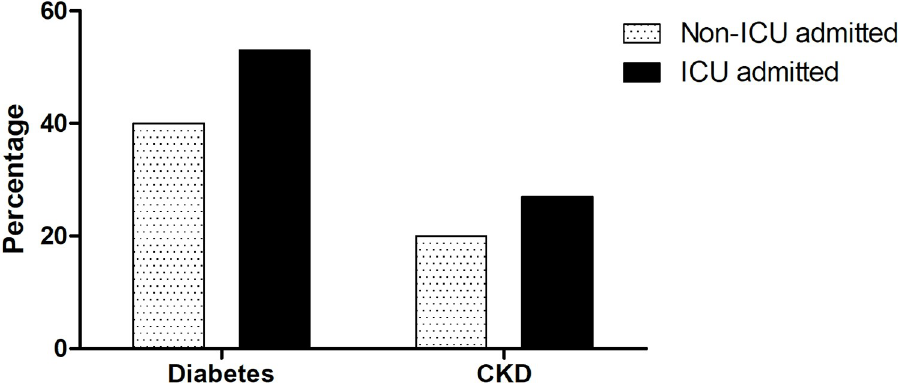
Fig 2. Bar graph representing the significant comorbidities among the COVID-19 positive patients admitted.